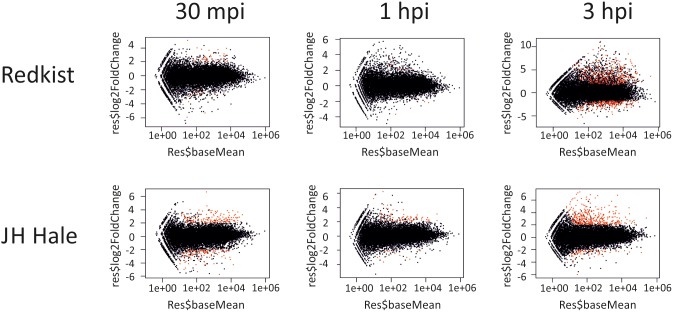
MA plot of genes differentially expressed (red dots) by two peach varieties during a time course after Xap infection.DEGs were selected by filtering based on log2 (FC) > 2, or log2 (FC) < -2, and FDR < 0.05.